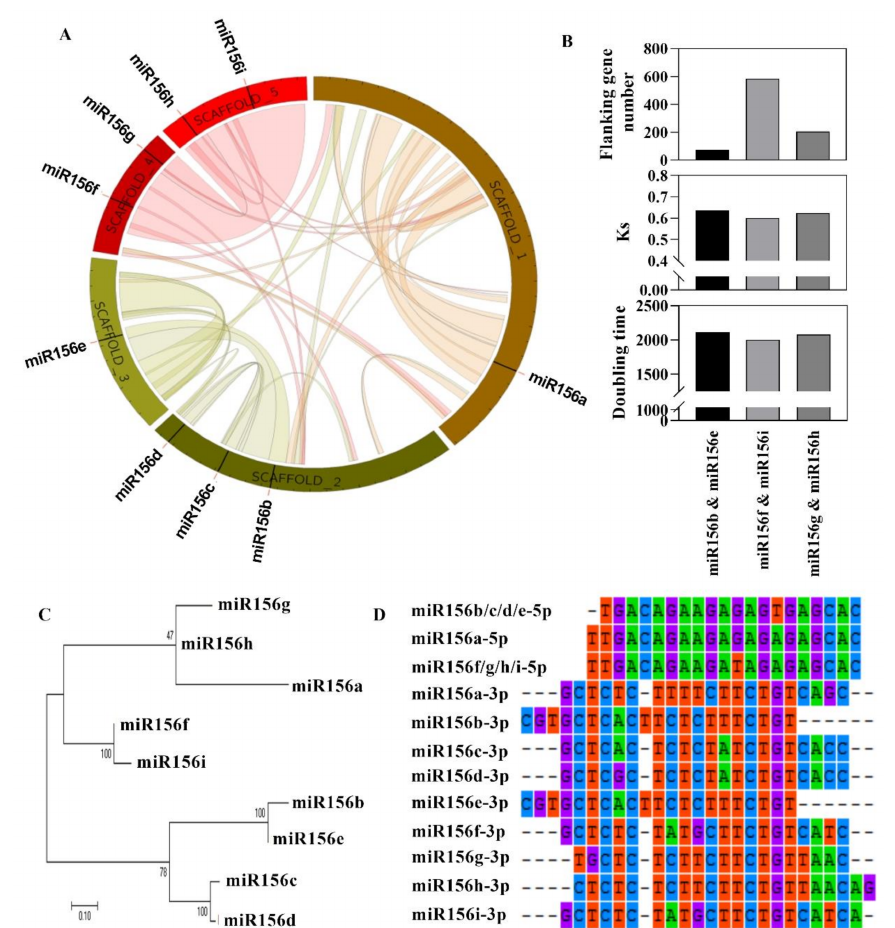
Figure 5. Evolutionary analyses of the lotus miR156 gene family. ( A ) Chromosome location and collinearity of the miR156 gene. ( B ) Duplication event of a large segment of the chromosome. ( C ) Phylogenetic tree of the miR156 gene family. ( D ) Mature sequence of